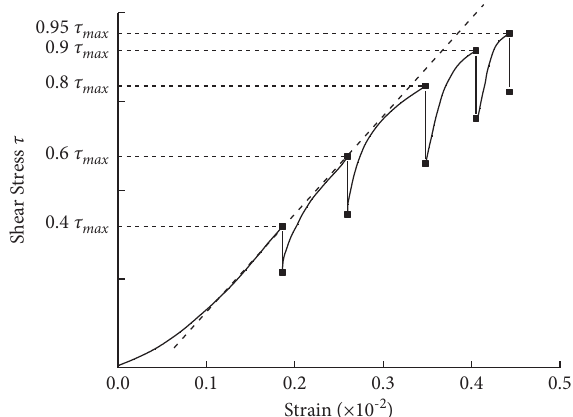
Figure 14: Stress-strain curve of the 45 ° structural surface during the relaxation